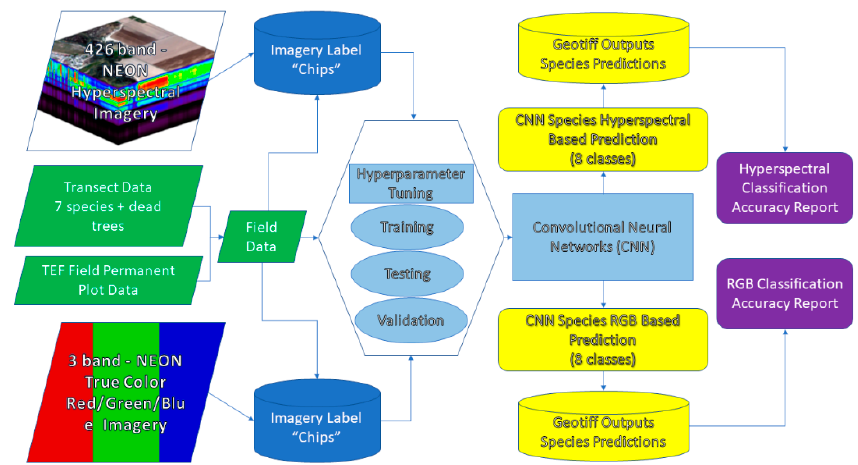
Figure 3. Schematic of the data processing flow and architecture. Datasets (left), Field data (green), convolutional neural network (CNN) model (light blue), CNN Predictions (yellow) Accuracy Reports